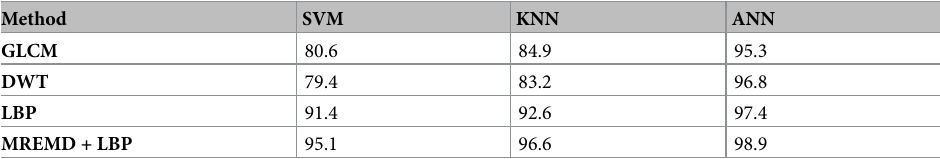
Table 3. Comparison of different classifier